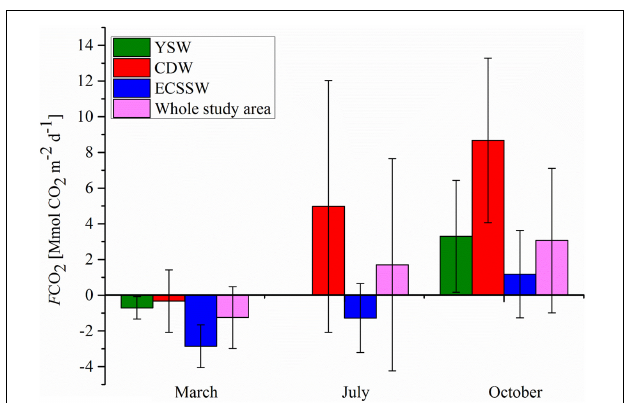
FIGURE 5 | Air–sea CO 2 fluxes in the different water types in March, July, and October, 2018. The F CO 2 in this figure were the average values calculated by the three gas exchange formulas mentioned in Section “CO 2 flux calculations.”